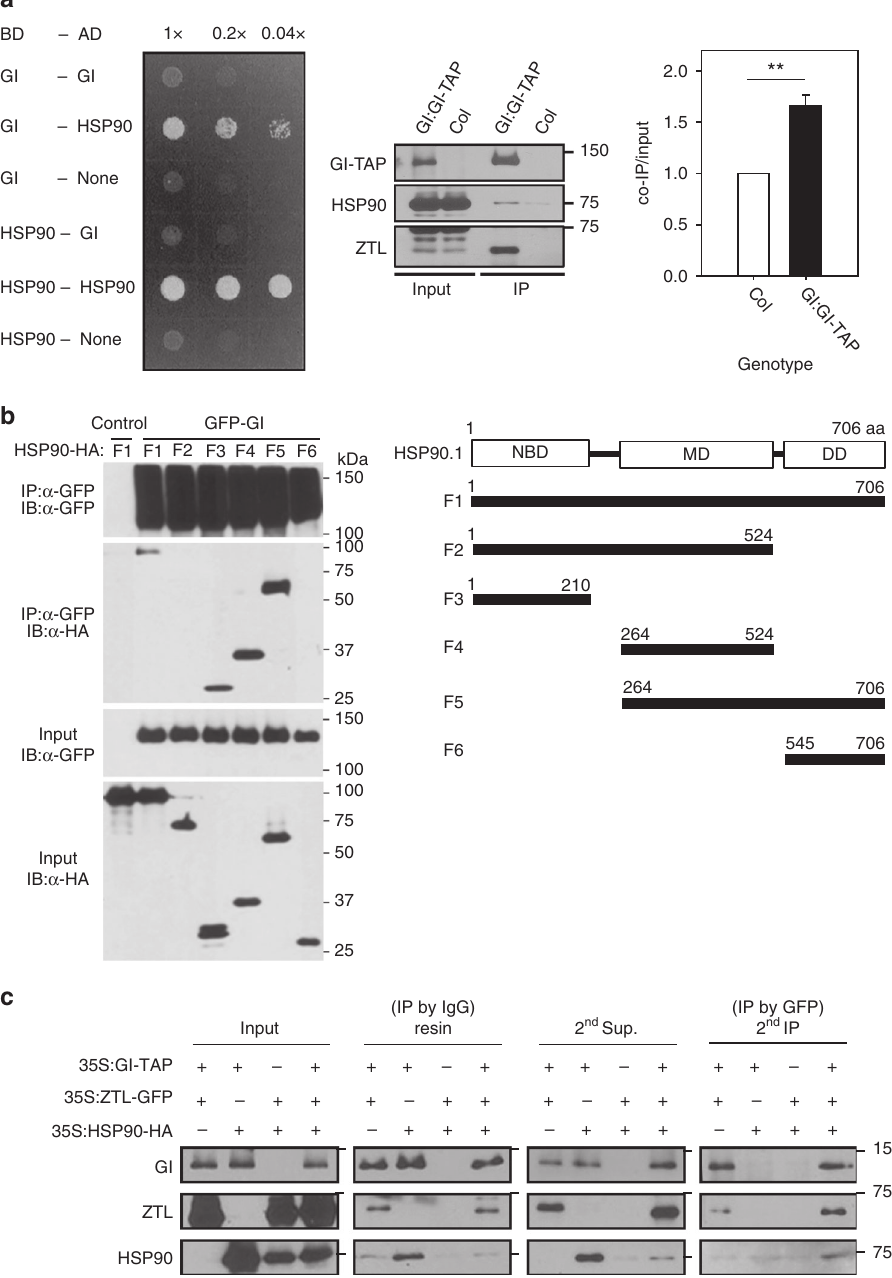
Fig. 4 GI complex formation with ZTL and HSP90 in vivo. a GI and HSP90 interact directly in yeast ( left panel ) and in planta ( right panel ). Full-length GI and HSP90 protein interaction via yeast two-hybrid was determined by growth on leucine de fi cient media. Transgenic Arabidopsis expressing GI:GI-TAP immunoprecipitates with endogenous HSP90 and ZTL ( right panels ). Untransformed Col controlled for non-speci fi c HSP90 interaction. Quanti fi cation of HSP90 in GI-TAP immunoprecipitations (IPs) ( far right panel ; mean ± s.e.m.; ** P < 0.01) ( n = 4). b HSP90 deletion interactions with GI. Agrobacteria harboring GI-GFP or HSP90 and its respective deletions tagged with 3 × HA were co-in fi ltrated into N. benthamiana leaves. Anti-GFP (IP) were followed by detection of co-immunoprecipitated HSP90-HA and respective deletions. Representative of three trials with similar results. Right panel : HSP90 domain structure and respective deletion scheme. IP immunoprecipitating antibody, IB immunoblot antibody, NBD nucleotide-binding domain, MD middle domain, DD dimerization domain. c GI, ZTL, and HSP90 form a tripartite protein complex in planta. Sequential co-immunopreciptations used GI-TAP in the primary IP followed by IP of ZTL-GFP (anti-GFP ab) from the protease-released supernatant (2nd Sup.). The fi nal detection of HSP90-HA (anti HA ab) in lane 4 indicates HSP90-HA associated with ZTL-GFP from the fi rst IP. N. benthamiana leaves were triply co-in fi ltrated with 35S:GI-TAP/35S:HSP90-HA/35S:ZTL- GFP simultaneously or in all pairwise combinations. Representative of three independent